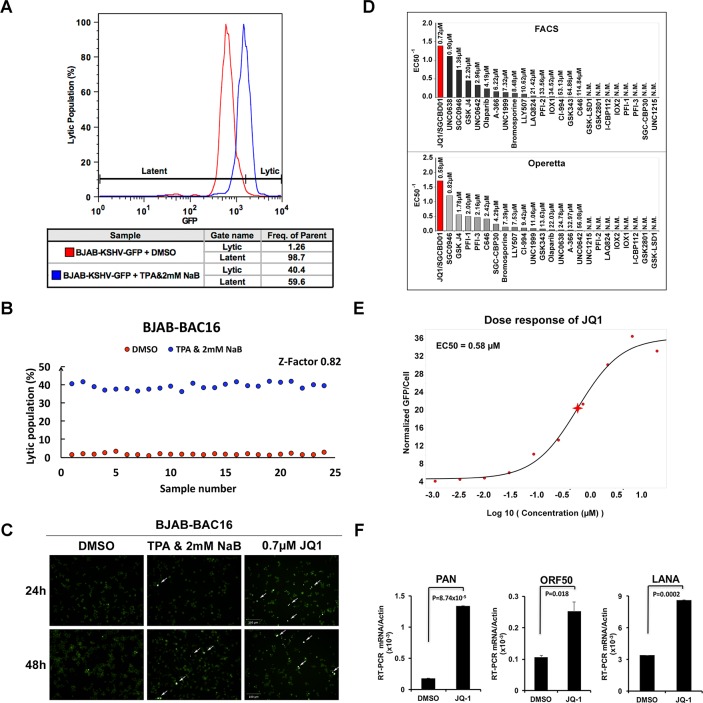
Identification of JQ1 in a high-throughput screen for epigenetic regulators of KSHV lytic reactivation.(A) BJAB-BAC16 cells were assayed by FACS for GFP fluorescence intensity after 48 hr incubation with 1% DMSO (red) or TPA+2mM NaB (blue). (B) Z-factor calculation for high-throughput FACS analysis of KSHV lytic population. (C) Operetta high-content image analysis for GFP intensity in BJAB-BAC16 cells treated for 24 or 48 hr with 1%DMSO (left panels), TPA+2 mM NaB (middle panel), or 0.7 μM JQ1(right panel). (D) Summary of high-throughput screening using FACS (top panel) or Operetta (lower panel). Compound activity was ranked from left to right based on the reciprocal of the EC50 value calculated for each compound. (E) EC50 calculation for JQ1 using Operetta high-content imaging. (F) RT-qPCR for PAN, ORF50, and LANA transcripts relative to cellular actin in BJAB-BAC16 cells treated for 24 hrs with 1% DMSO or 4 μM JQ1. Error bars represent standard deviation from mean (sdm) and p-values were calculated by 2-tailed student t-test.